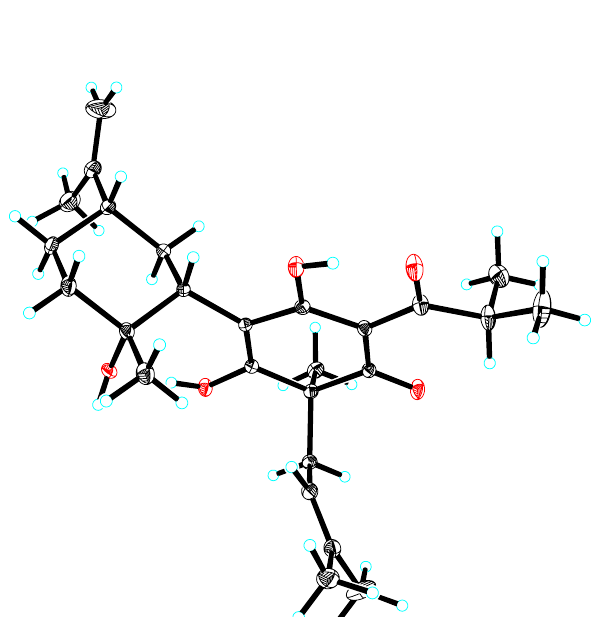
Fig. 2 Key HMBC and 1 H– 1 H COSY correlations of 1 – 5